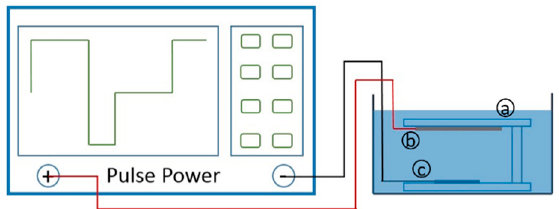
Figure 2. Experimental set-up schematic for through-silicon-vias (TSVs) filling ( a ) Teflon jig (13 cm × 16 cm × 0.5 cm, h = 3 cm); ( b ) copper anode; ( c ) silicon wafer cathode to be electrodeposited (13 mm × 21 mm × 0.5 mm).